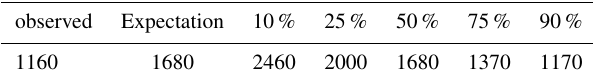
Base on Eq. (6), the conditional Log normal probability distribution function f ( y ) at x = x ∗ can be derived: